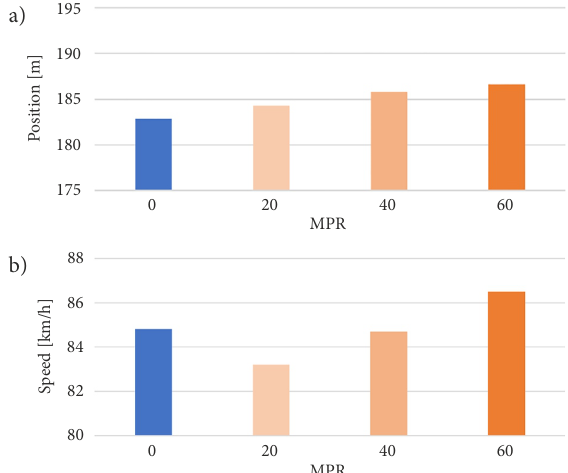
Figure 10. Merging position on the acceleration lane [m] (a) and average speed on the acceleration lane [km/h] (b) – driving as usual